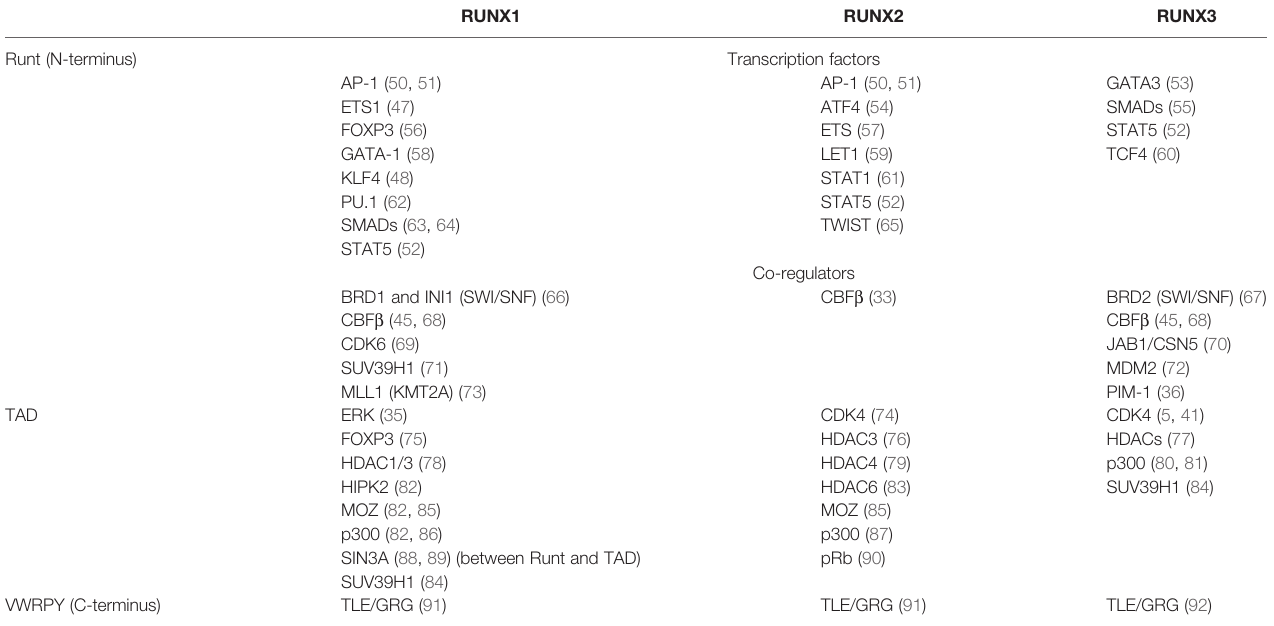
TABLE 1 | Human and murine Runx family protein domain